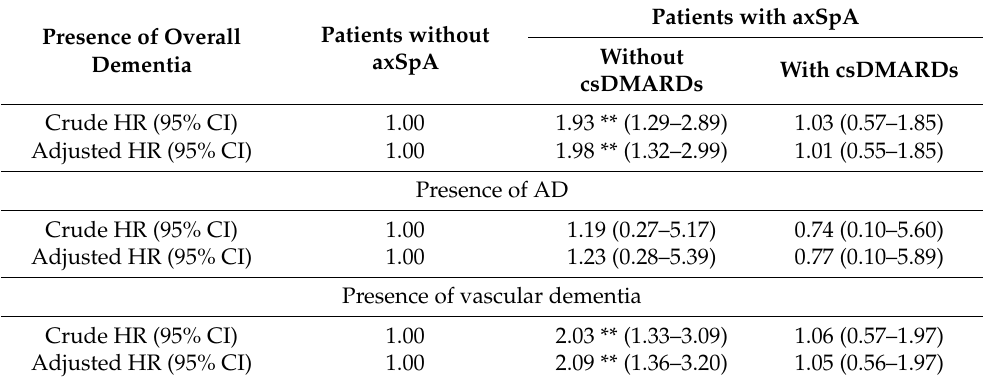
Table 3. Crude and adjusted hazard ratios (HRs) and 95% confidence intervals (CIs) for dementia during the 7-year follow-up.